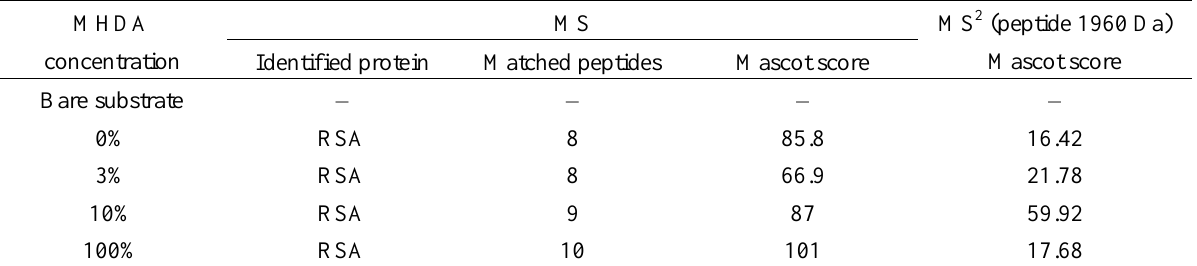
Table 1. MS and MS 2 results obtained on protein modified GaAs